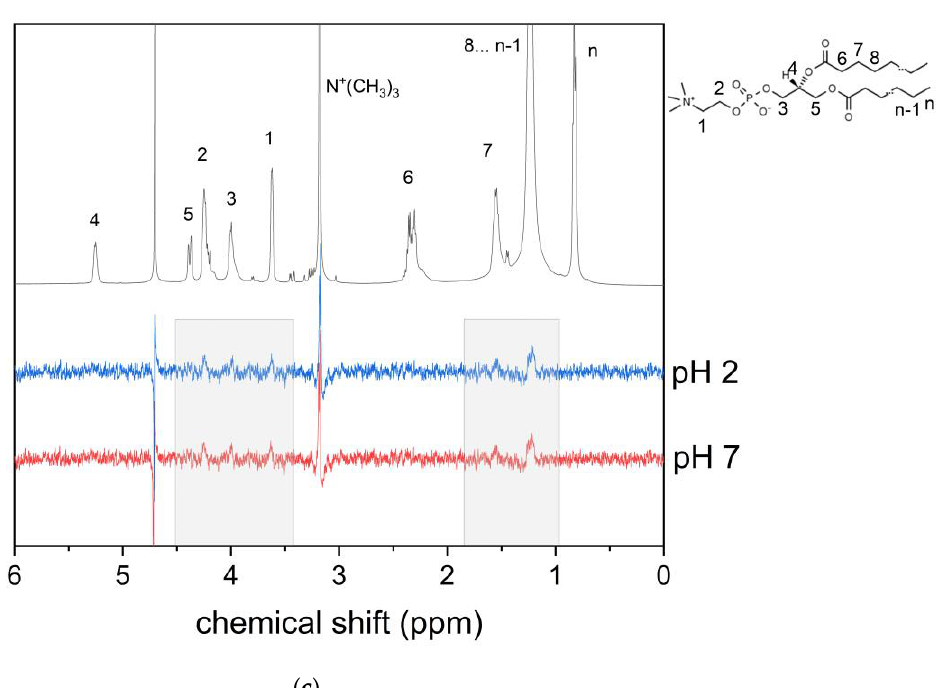
Figure 3. 1D NOESY spectra (blue and red lines) and 1 H NMR spectra (gray lines) of ( a ) 2 mM KP; ( b ) 2 mM KP + 4 mM Trp, KP protons; ( c ) 2 mM KP + 4 mM Trp, Trp protons in DHPC/DMPC bicelles at different pH values. Mixing time was 500 ms. Selective excitation of KP protons at 7.8 ppm (Figure 1, blue circles) and Trp protons at 7.2 ppm (Figure 1, red circle) was performed.